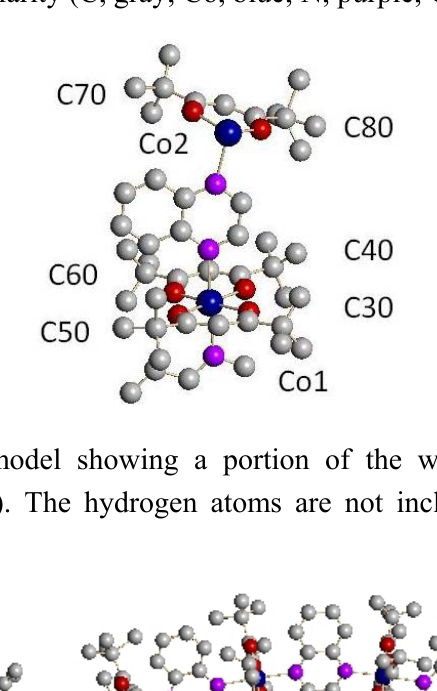
atoms are not included for clarity (C, gray; Co, blue; N, purple; O, red).